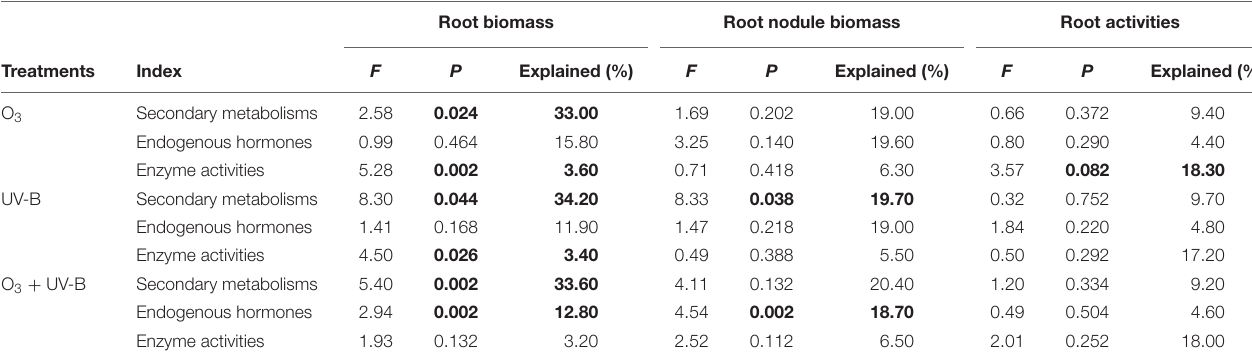
TABLE 5 | Results of redundancy analysis (RDA) of the modulation of secondary metabolisms, endogenous hormones and enzyme activities in response to elevated O 3 treatment